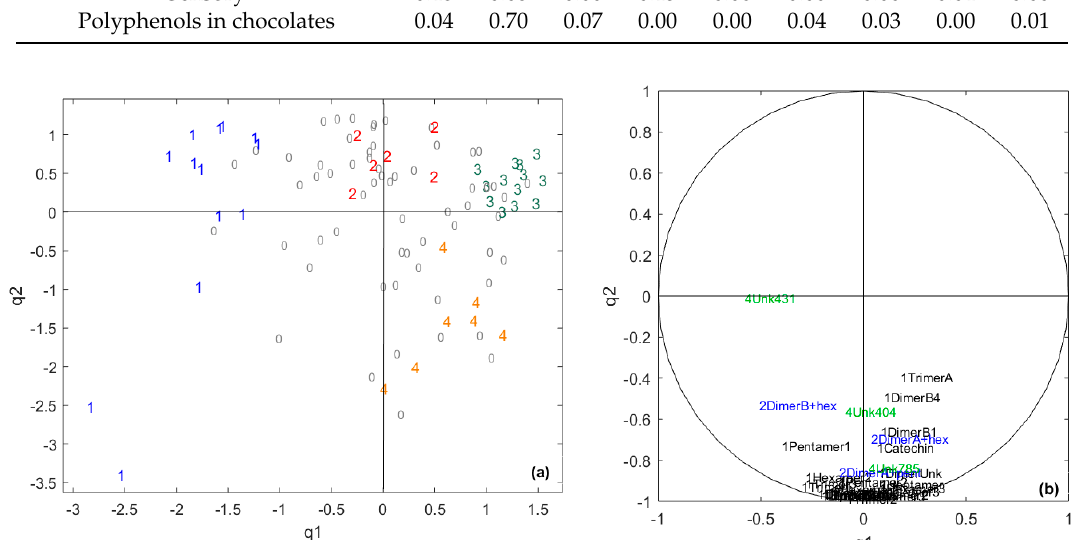
Table 1. Values of the specific weights (%) of each component (q1 through q9) calculated by the Figure 2. ( a ) Projection of the samples on the two first scores of the Common Component and Specific Figure 2. ( a ) Projection of the samples on the two first scores of the Common Component and Specific Common Component and Specific Weights Analysis (CCSWA) with chocolate polyphenolic data and Weights Analysis (CCSWA) on sensory and chocolate polyphenols data for the two first common Weights Analysis (CCSWA) on sensory and chocolate polyphenols data for the two first common sensory data. components, the so-called “common space”. 1 = core pole 1, 2 = core pole 2, 3 = core pole 3, 4 = core pole components, the so-called “common space”. 1 = core pole 1, 2 = core pole 2, 3 = core pole 3, 4 = core 4 and 0 = samples not belonging to any core pole. ( b ) The correlation circle for the polyphenol variables. pole 4 and 0 = samples not belonging to any core pole. ( b ) The correlation circle for the polyphenol Variables are coded with di ff erent colors: black = flavan-3-ols, blue = glycosylated flavan-3-ols and variables. Variables are coded with different colors: black = flavan-3-ols, blue = glycosylated flavan- green = unknown 3-ols and green = unknown compounds.